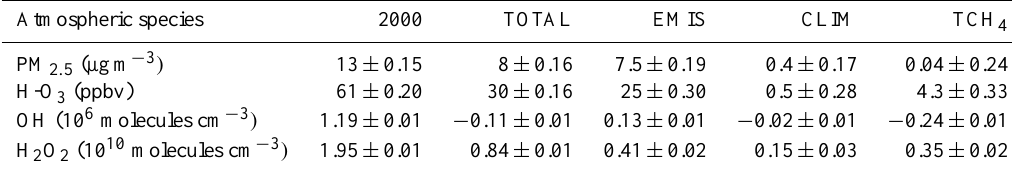
Table 3. Year 2000 global population-weighted annual mean surface PM 2 . 5 and H-O 3 (health-relevant O 3 , defined in Sect. 2), tropospheric mean mass-weighted OH and H 2 O 2 concentrations, and their changes from 1860 to 2000 driven by all changes (TOTAL), changes in emissions of short-lived reactive pollutants (EMIS), changes in climate (CLIM), and changes in tropospheric CH 4 concentration (TCH 4 ) . Results are reported for 10-yr model simulations as annual average ± standard